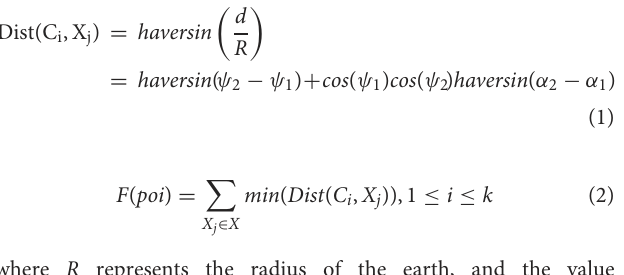
( ψ 2 , α 2 ).During evolution, the fitness function (Equation 1) is used to calculate the sum of the distances (Equation 2) (Wang et al., 2014) from all interior points to the cluster